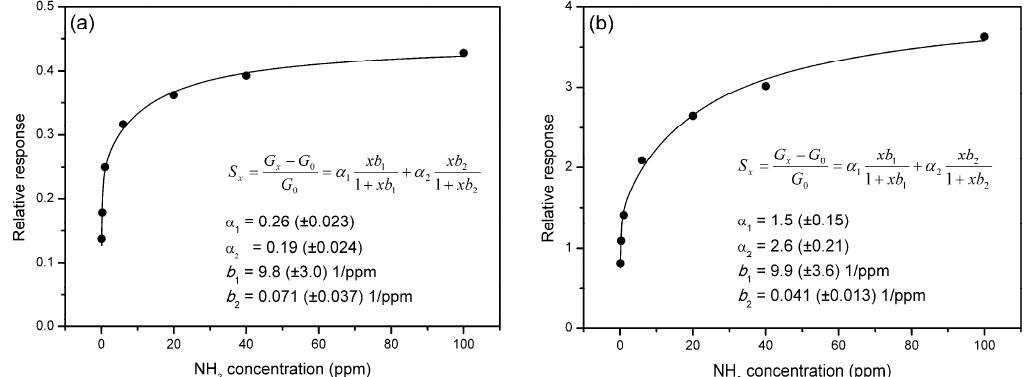
Figure 6. Dependence of stationary relative response amplitudes on NH 3 concentration (black dots) for ( a ) CVD graphene and ( b ) epitaxial graphene sensors functionalised with V 2 O 5 . The continuous lines are fitting curves to two-site Langmuir adsorption model (Equation (2)). The coefficients of the modelled curves are also shown.